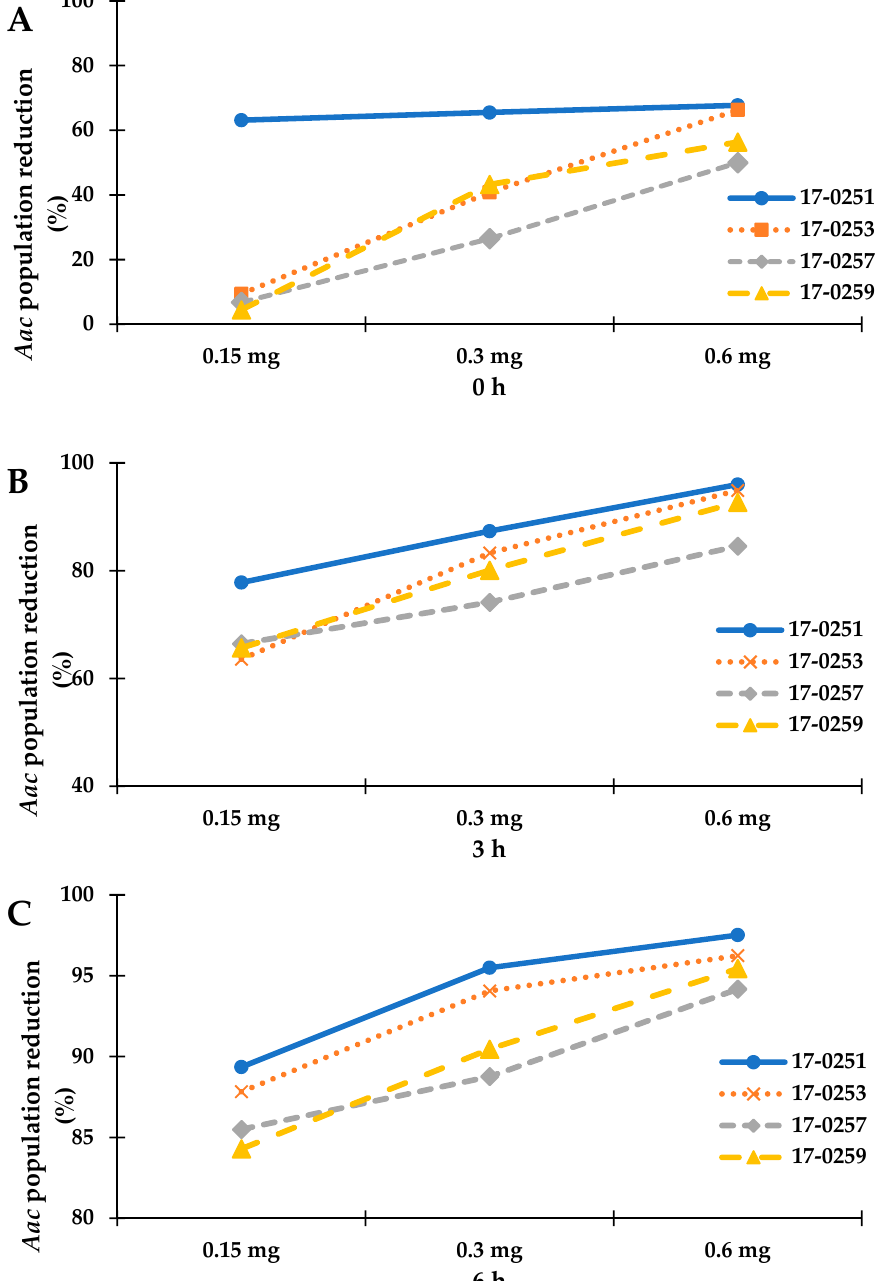
Figure 1. Represent the time kill assay graph of endophytic fungal crude extracts against Aac , JT-0003; ( A ) incubated for 0 h, ( B ) incubated for 3 h, and ( C ) incubated for 6 h. Exponential graph of time of Neocosmospora sp. MFLUCC 17-0251, MFLUCC 17-0253, MFLUCC 17-0257 and MFLUCC 17-0259 were diluted in 10% DMSO and tested at the indicated concentrations.